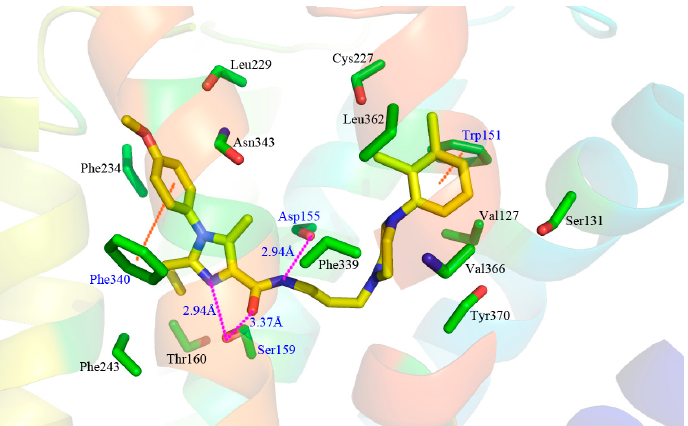
Figure 9. Compound 13 and the interaction groups of the key amino acids are depicted in sticks and highlighted with yellow and green carbons, respectively. N-atoms, O-atoms and S-atoms are colored blue, red and yellow, respectively. H-bond and π - π stacking interactions are represented as purple and orange dashed lines, respectively.